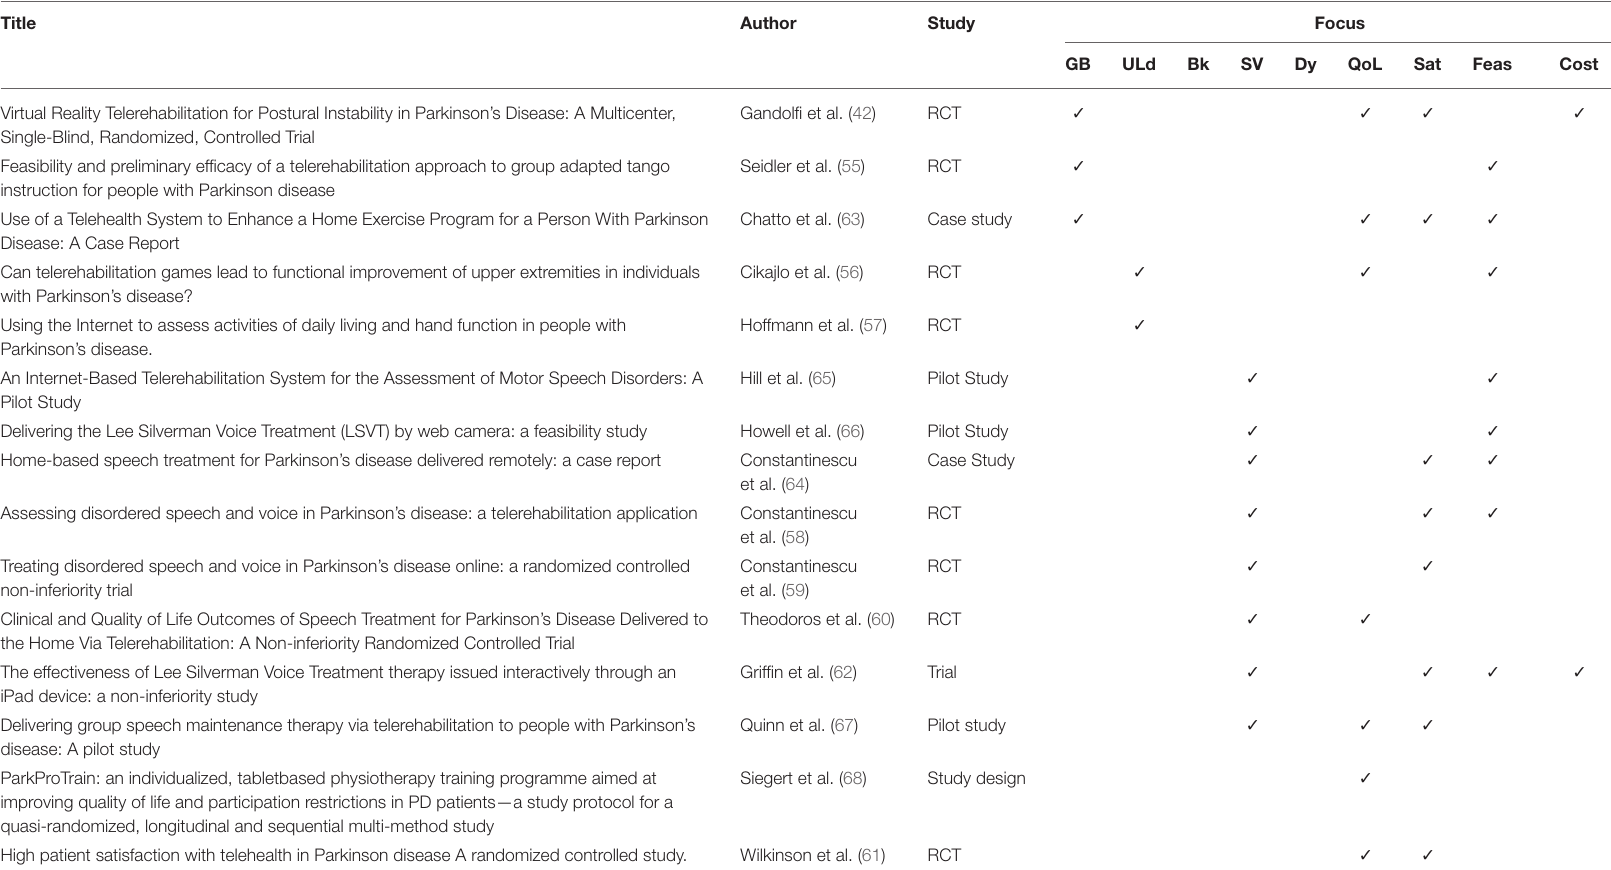
TABLE 4 | Focus on points of interest of the included